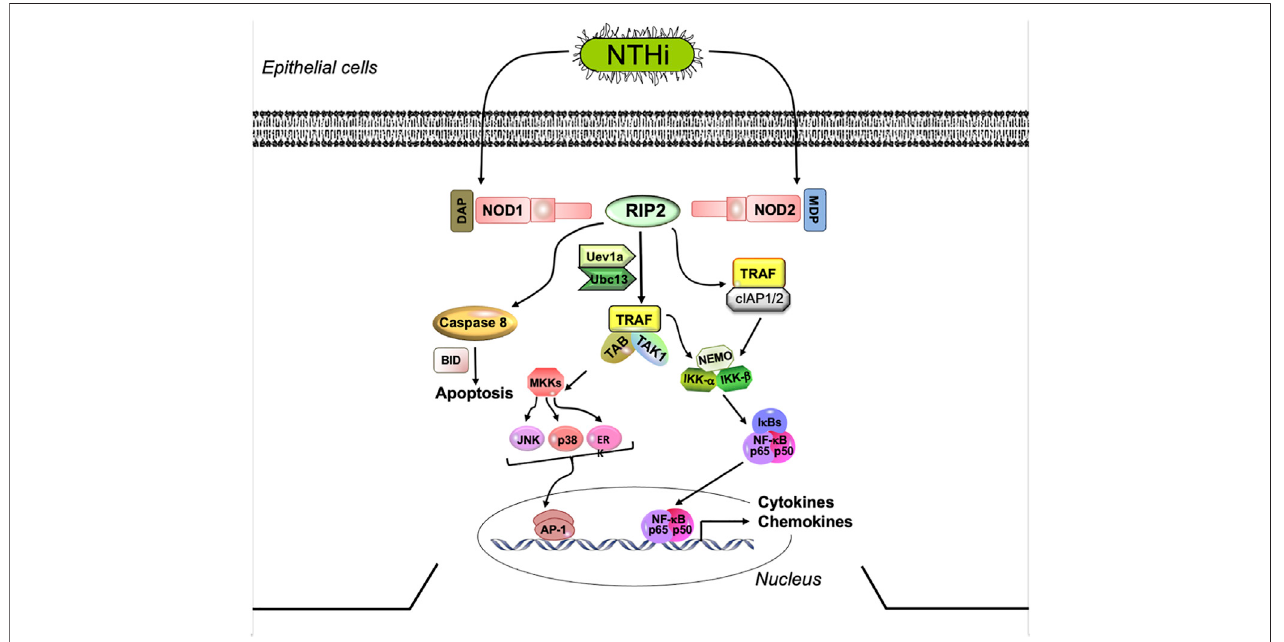
FIGURE 1 | NOD signaling via the RIP2 adaptor. NOD-mediated RIP2 signaling strongly stimulates the production of pro-in fl ammatory cytokines, via NF κ B and MAPK activation. Several parallel pathways can lead from RIP2 to in fl ammatory gene expression. NOD, nucleotide-binding oligomerization domain; RIP2, receptor interacting protein kinase 2; IRAK1, interleukin-1 receptor-associated kinase 1; TRAF2,5,6, tumor necrosis factor receptor associated factors 2, 5, and 6; TAK1, mitogen-activated protein kinase 7 (TAK1); NF κ B, nuclear factor of kappa light polypeptide gene enhancer in B-cells; p50 NF κ B subunit 1; p65, NF κ B subunit 3,TNF α , tumor necrosis factor alpha; IL,